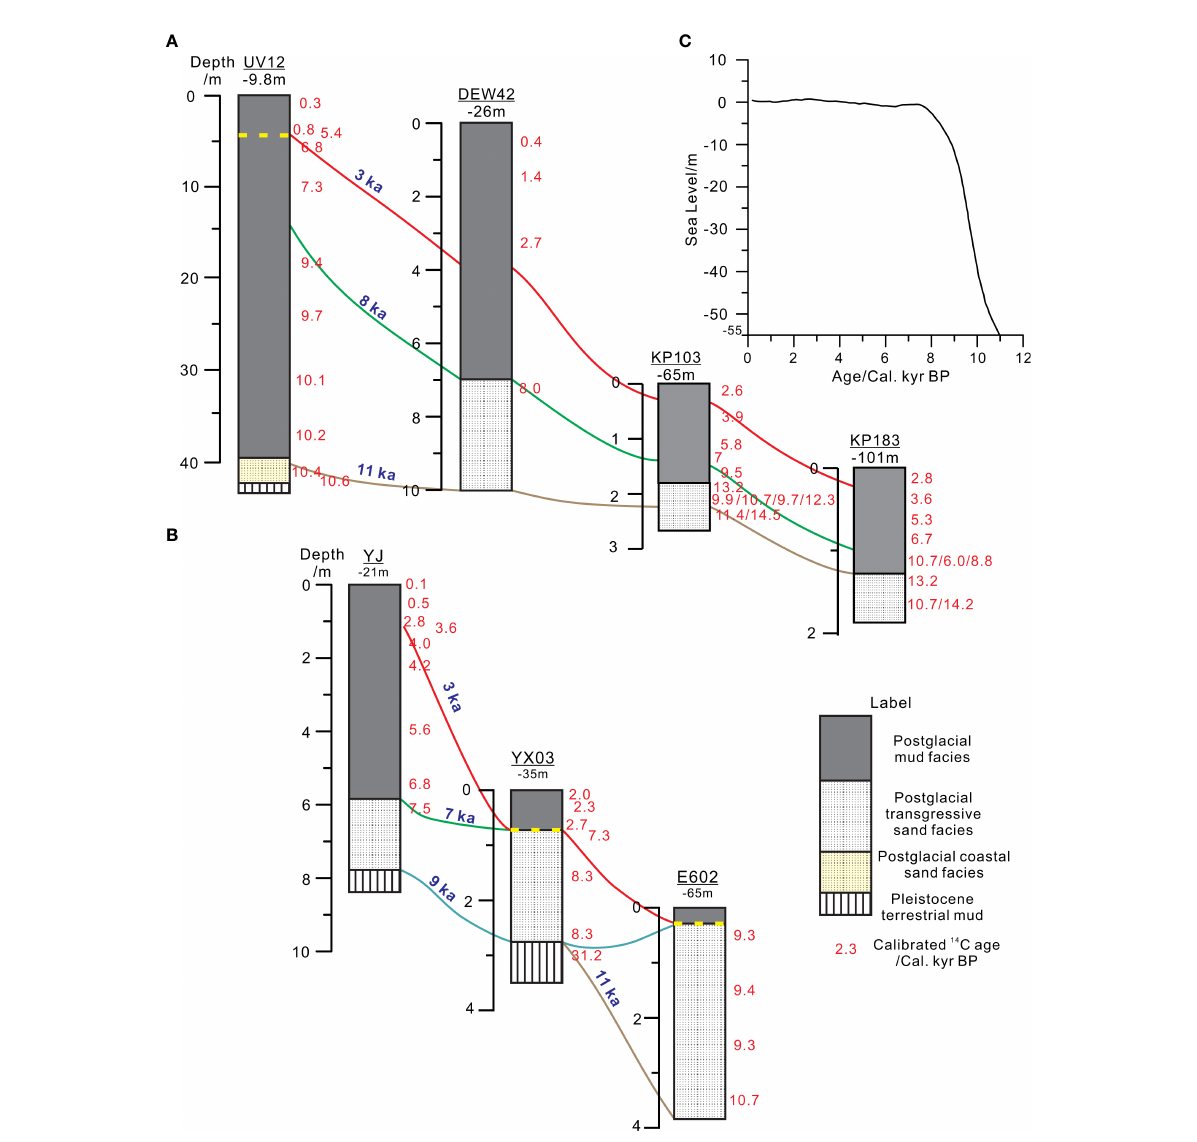
FIGURE 6 Two cross sections of Holocene sedimentary sequence on the north-western SCS shelf ( (A) in the east; (B) in the west). (C) Sea-level changes since 11 ka BP according to Xiong et al. (2018). Reference cores were published by Xiao et al. (2013); Huang et al. (2018); Xiong et al. (2018) and Yim et al. (2006). The location of cores can be found in Figure